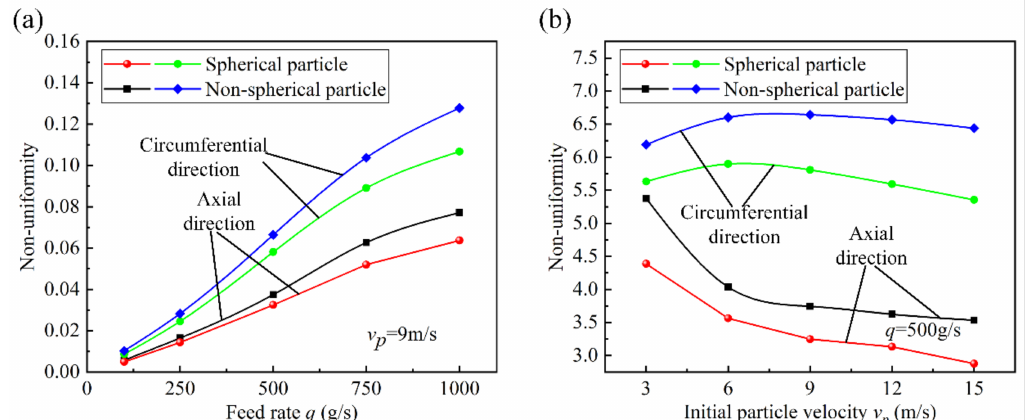
Figure 16. The effect of working parameters on non-uniformity of each calculation domain. ( a ) feed rate ( b ) initial particle